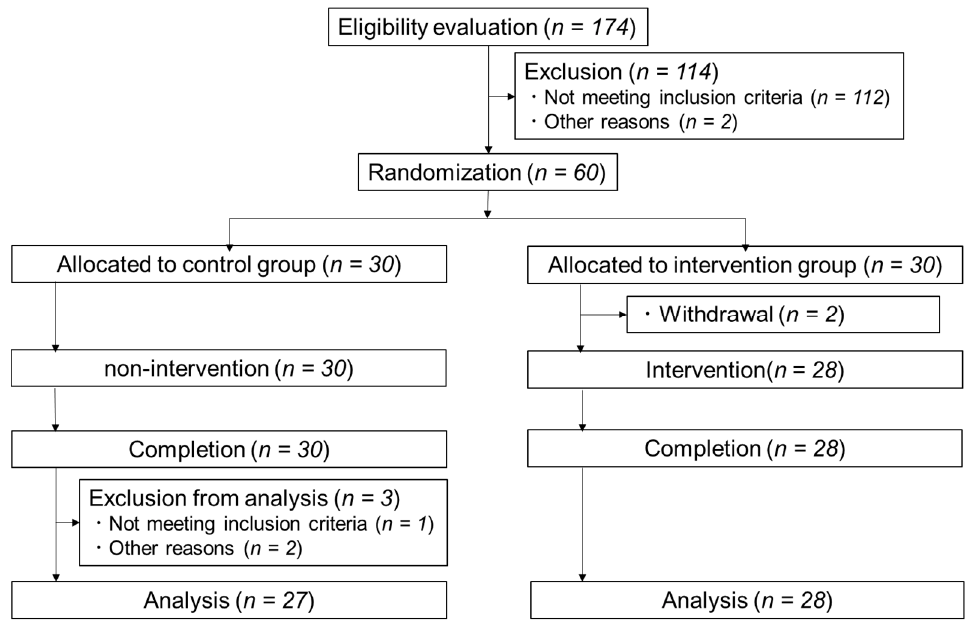
Figure 1. Flow diagram for the involvement of subjects during the trial.